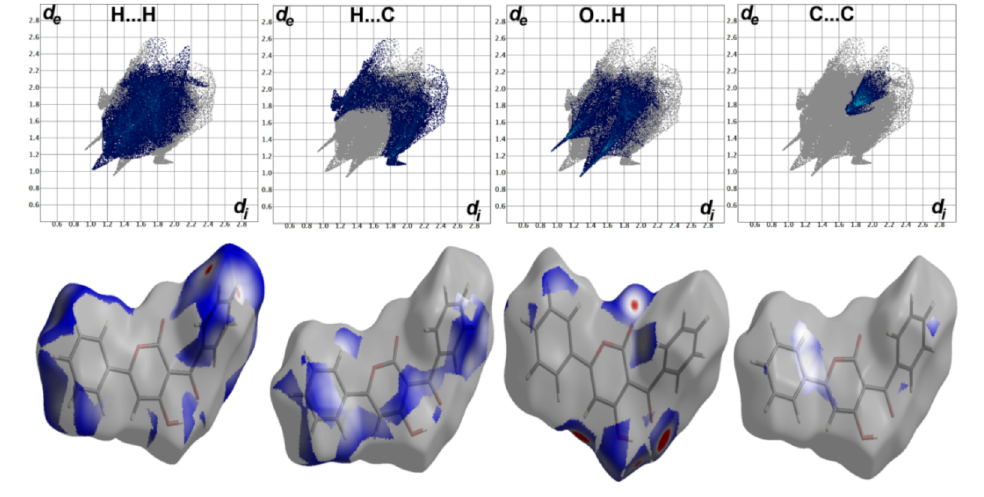
Figure 12. Decomposed fingerprint plots and d norm Hirshfeld surfaces of the most abundant interac- tions for 6K